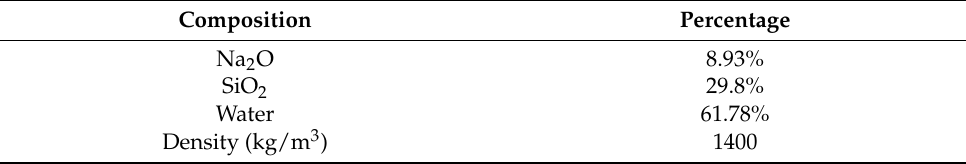
Table 3. The chemical composition of Na 2 SiO 3 .